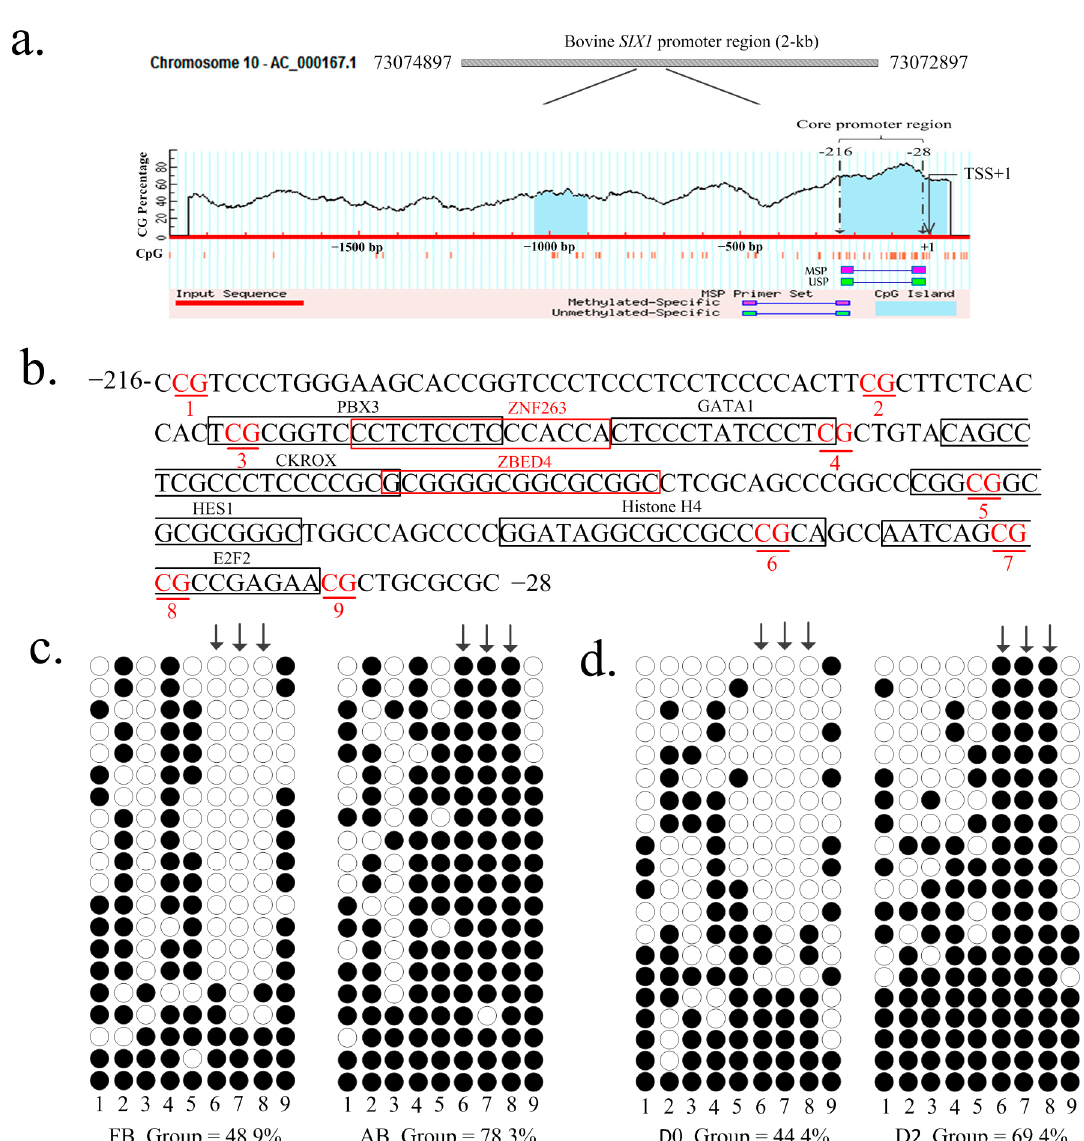
Figure 2. Methylation analysis of the bovine SIX1 gene in different developmental stages of individuals and cells. ( a ) Schematic representation of the SIX1 promoter. The bovine SIX1 gene is located on chromosome 10 and a 2-kb promoter region span from 73072897 to 73074897 (NCBI accession AC_000167.1). Blue background indicates the GC percentage and dashed lines show the core promoter region.The x -axis denotes the bp position in the 5 ′ untranslated region relative to transcriptional start sites (TSS). MSP and USP denote the methylated-specific primer and unmethylated-specific primer, respectively. ( b ) The sequence of the core promoter of the bovine SIX1 gene. The methylation loci are marked in red letters and putative transcription factor binding sites are boxed. ( c , d ) The percentages of the 9 CpG sites at different stages were analyzed using QUMA software. FB denotes the fetal bovine group and AB denotes the adult bovine group; D0 and D2 denotes QCMCs inducing stages. Each line represents one individual bacterial clone, and each circle one single CpG dinucleotide. Open circles and black circles show unmethylated and methylated CpGs, respectively.